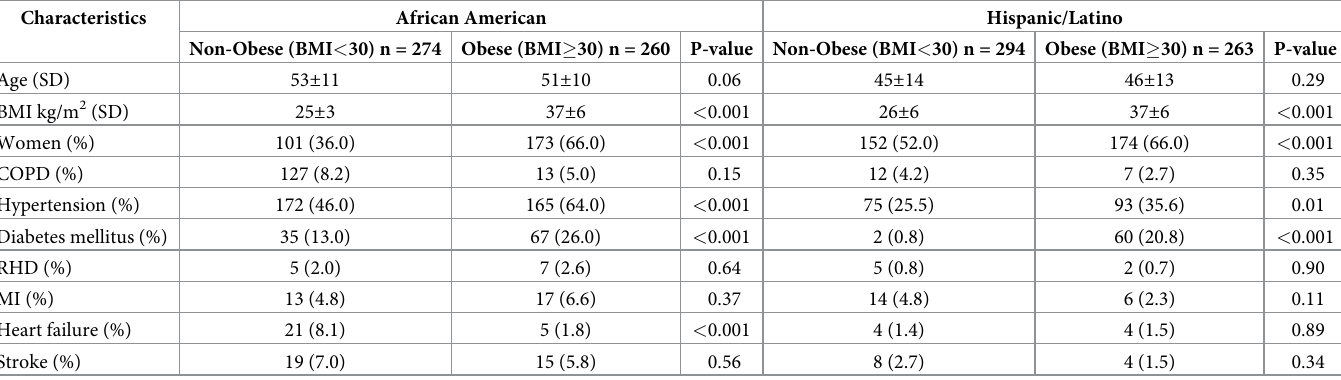
Abbreviations : BMI: Body mass index; COPD: Chronic obstructive pulmonary disease; MI, myocardial infarction; RHD: Rheumatic heart disease. Heart failure for Congestive heart